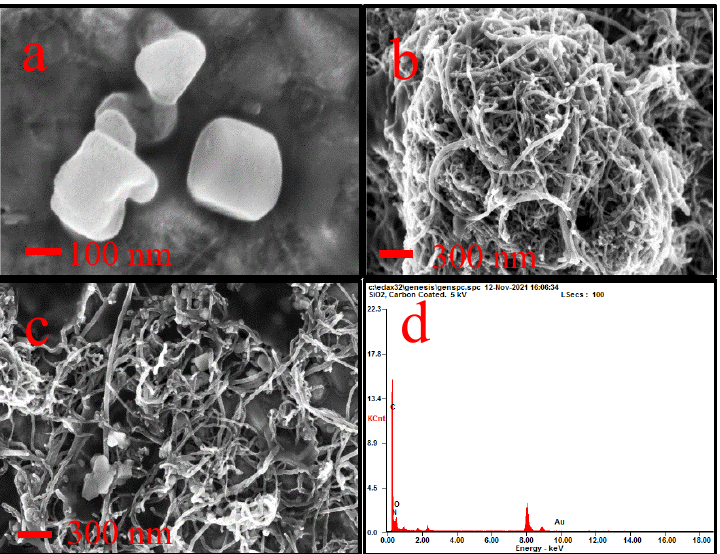
Figure 1. SEM images of PPRONPs—CDs ( a ), MWCNTs ( b ), and PPRONPs—CDs—MWCNTs ( c ), respectively. EDS of PPRONPs—CDs—MWCNTs ( d ).